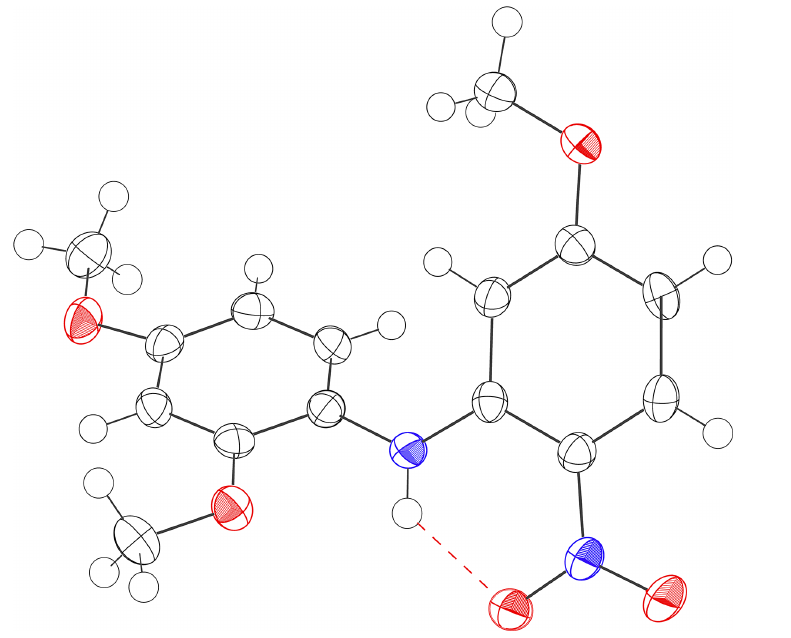
Fig 3. X-ray crystalstructure of